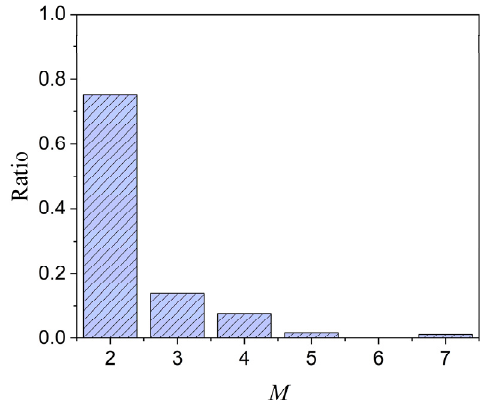
Figure 7. Distribution of multiplicity M.